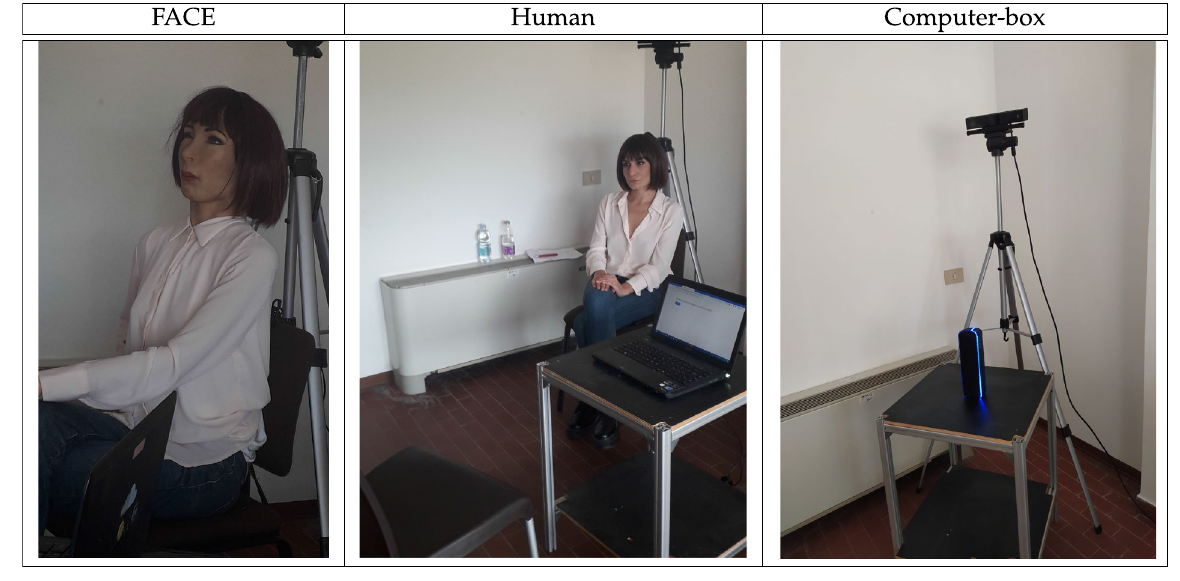
Figure 1. Three types of